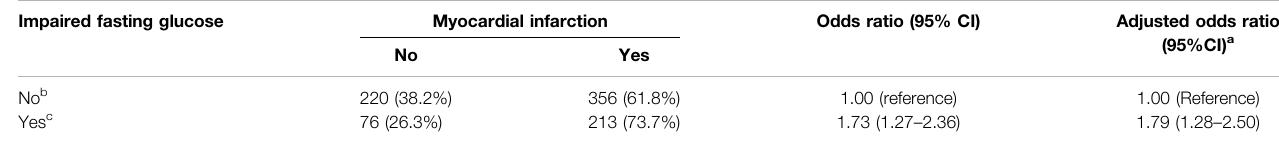
TABLE 3 | Impaired fasting glucose and myocardial infarction In patients with ≥ 50% stenosis in at least one coronary artery. Impaired fasting